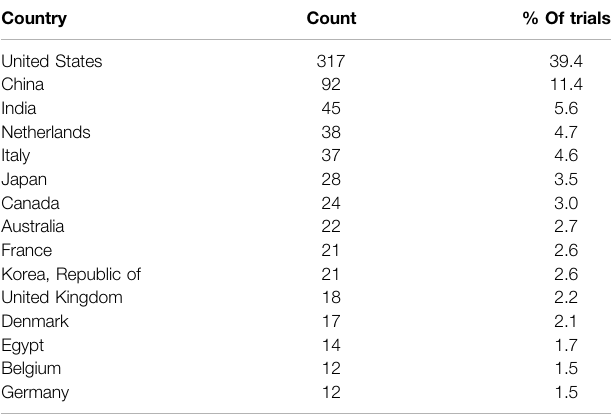
TABLE 4 | Trials by